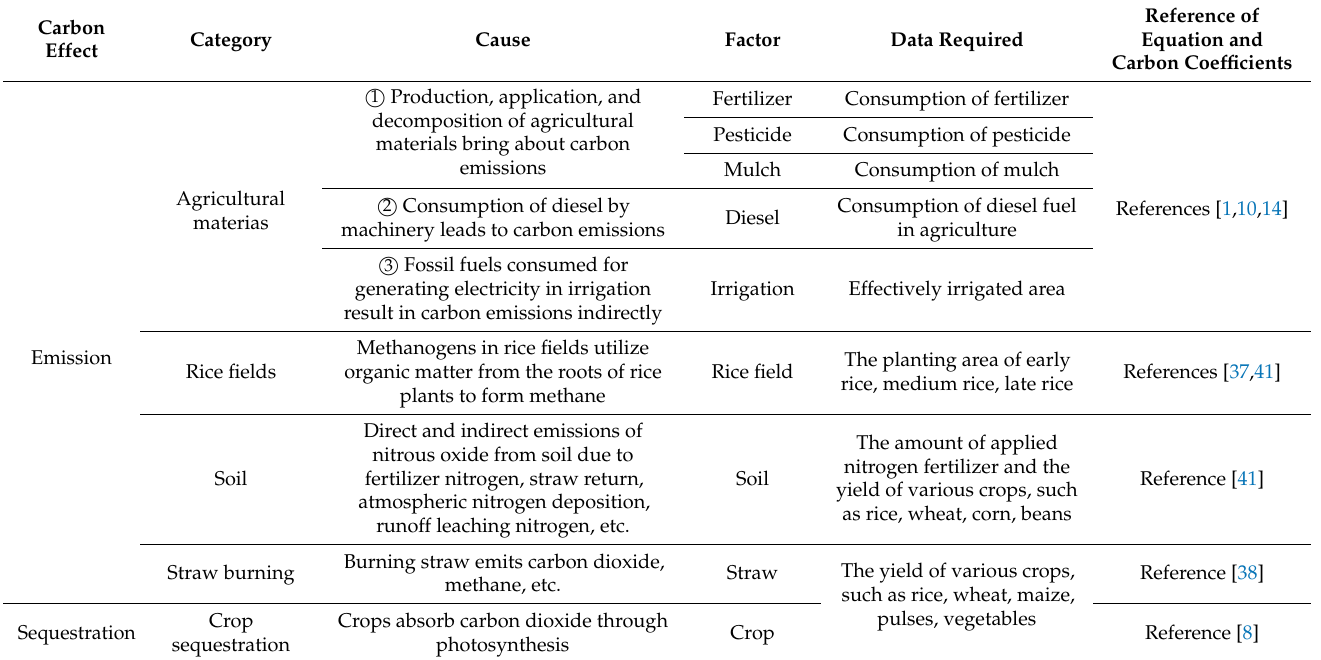
Table 1. Inventory for measuring the net carbon sequestration of cropland